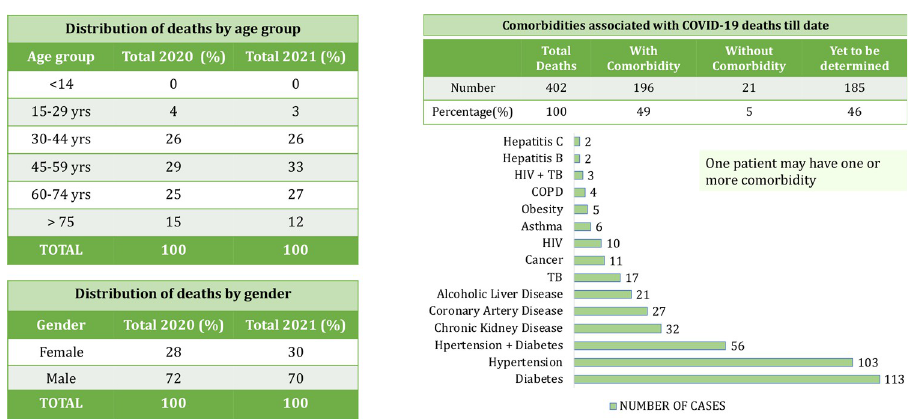
Fig 3. Age, gender, and comorbidity data for deaths provided in the weekly bulletin of Nagaland government on 5 June 2021 as examples of high-quality granular surveillance reporting.